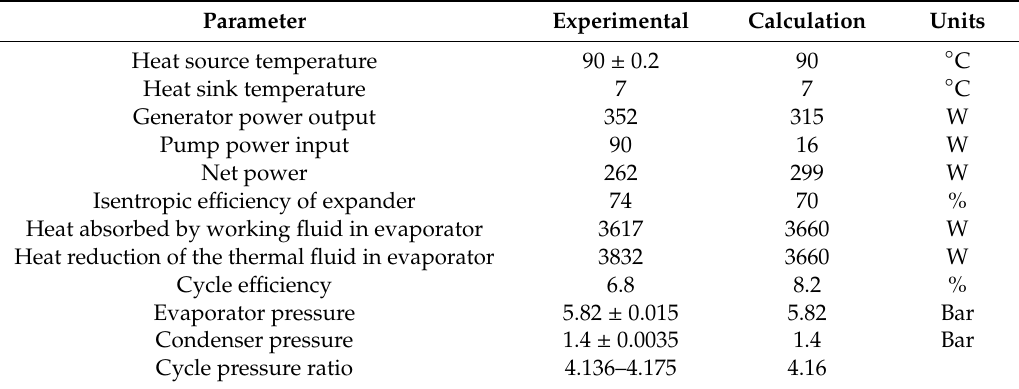
Table 4. Key data of the highest e ffi ciency